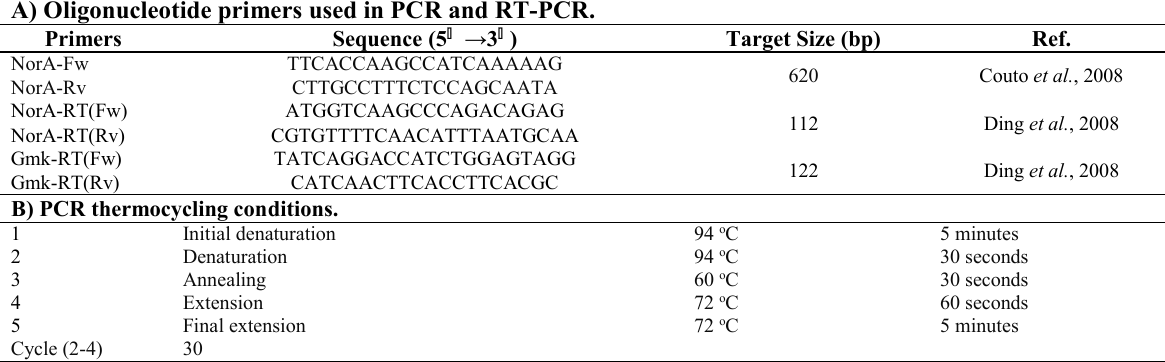
Table 1. Characteristics of PCR amplification and qPCR for norA